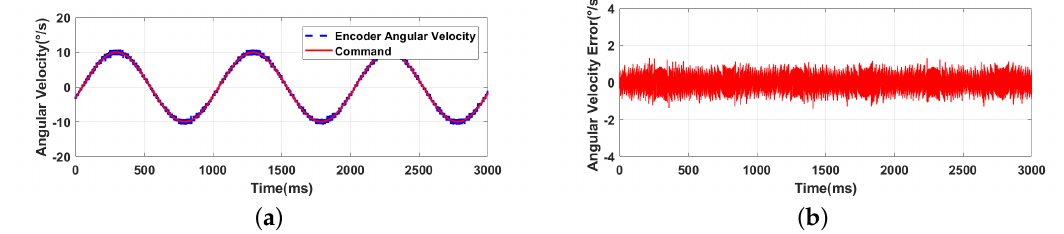
Figure 12. Group D: Proposed controller u ∗ c + u o + u f with a light base support. ( a ) Sine command and relative angular velocity; ( b ) Relative angular velocity error.